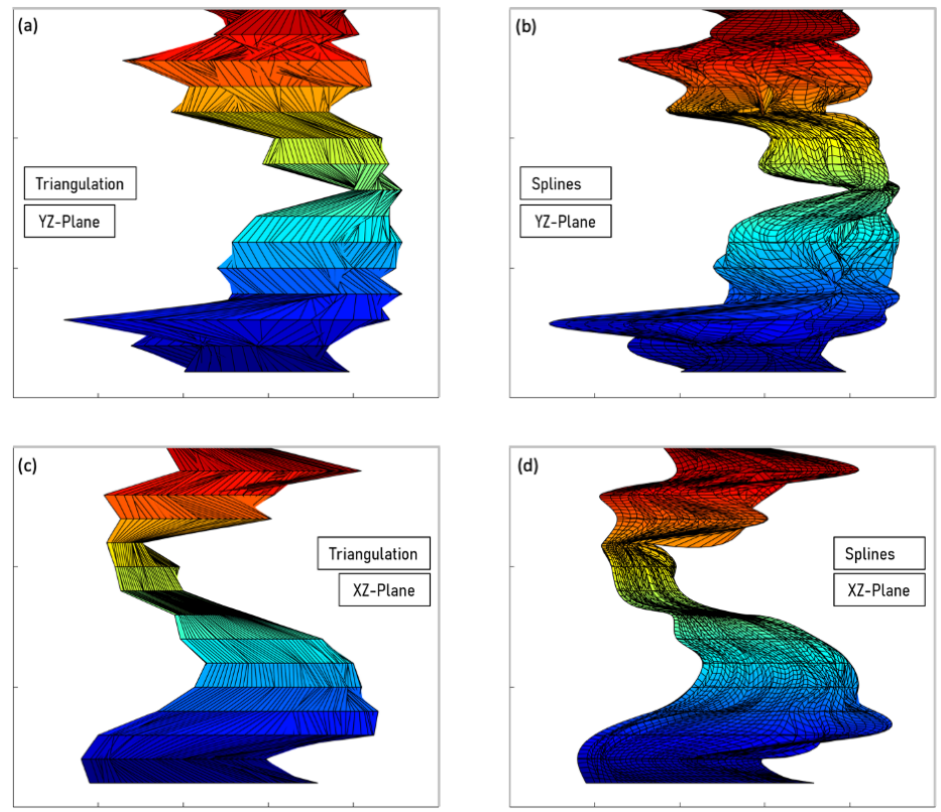
Figure 8. Reconstruction of the atheroma through a triangulation ( a , c ) and cubic spline surface approximation ( b , d